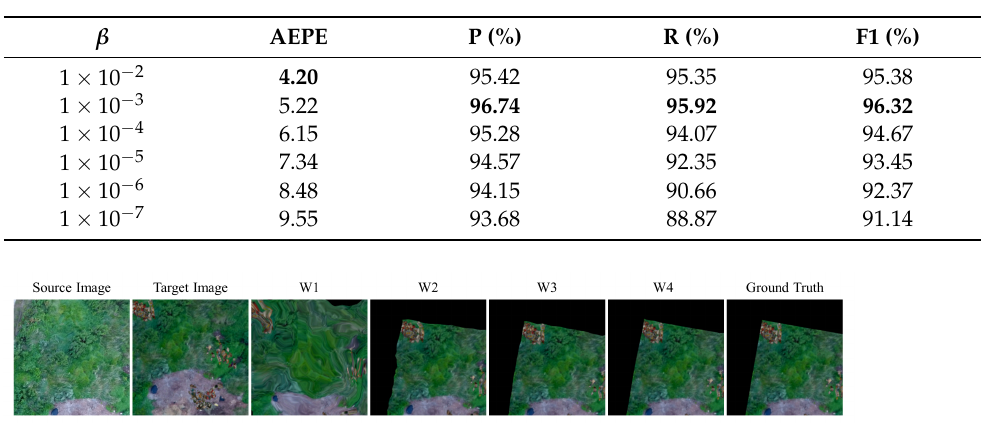
Table 3. Ablation study of hyperparameter β on our dataset.